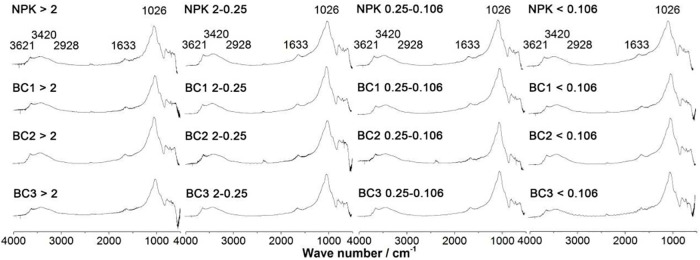
Effect of biochar content on organic carbon functional groups absorption spectra of soil samples.